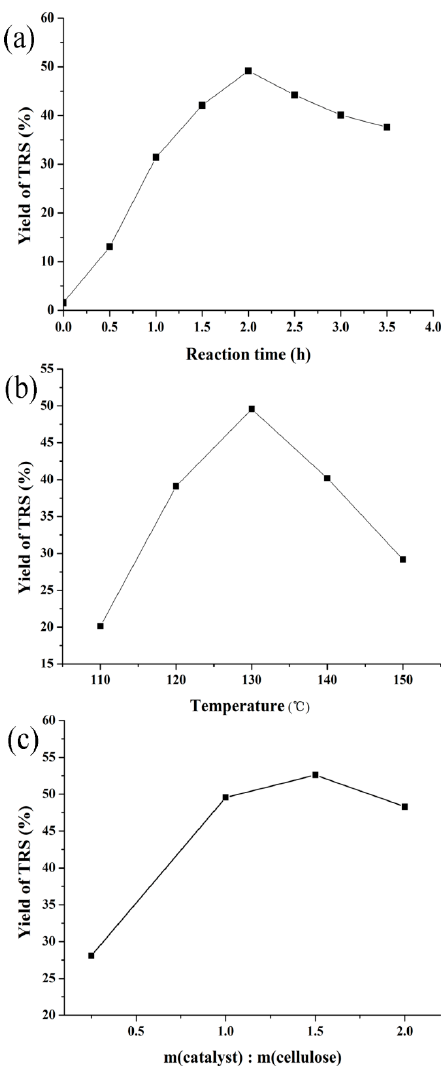
Figure 5. The effect of reaction time ( a ); temperature ( b ); and weight ratio of catalysts to cellulose ( c ) on TRS yields over H-Z-30. Reaction conditions: [BMIm]Cl (1.0 g), water (0.2 mL).